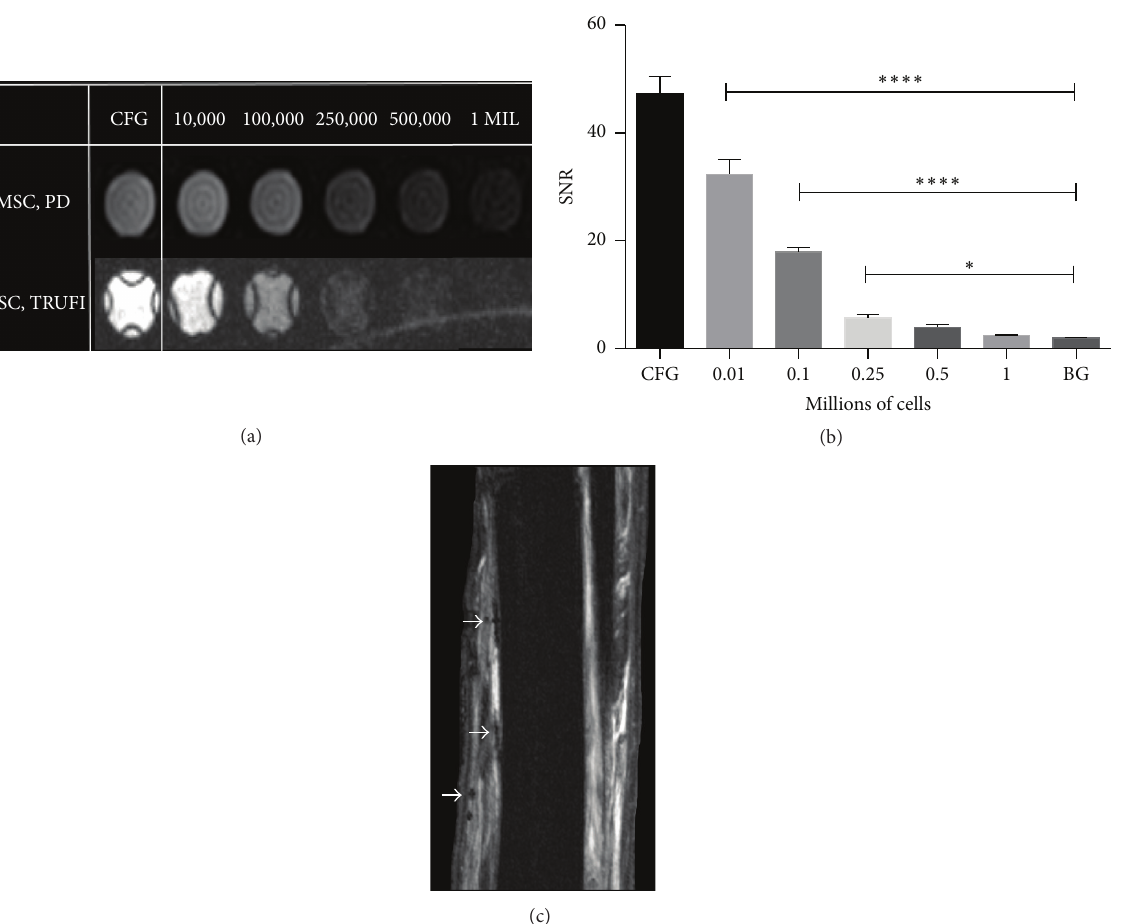
Figure 6: MRI data from cell suspensions in agar gel showing (a) PD (top row) and TRUFI (bottom row) images ranging from cell-free gel (CFG) up to 1 × 10 6 cells in a 96-well plate. (b) Signal-to-noise ratios (SNR) corresponding to the TRUFI images in (a). (c) Normal tendon following serial injection of 20, 10, 5, and 1 × 10 6 SPIO-labeled MSCs in order along the palmar aspect of the limb. SPIO-associated signal is only visible in the tissues surrounding the SDFT (arrows) ( ∗∗∗∗ 𝑝 < 0.0001 , ∗ 𝑝 < 0.05 ).